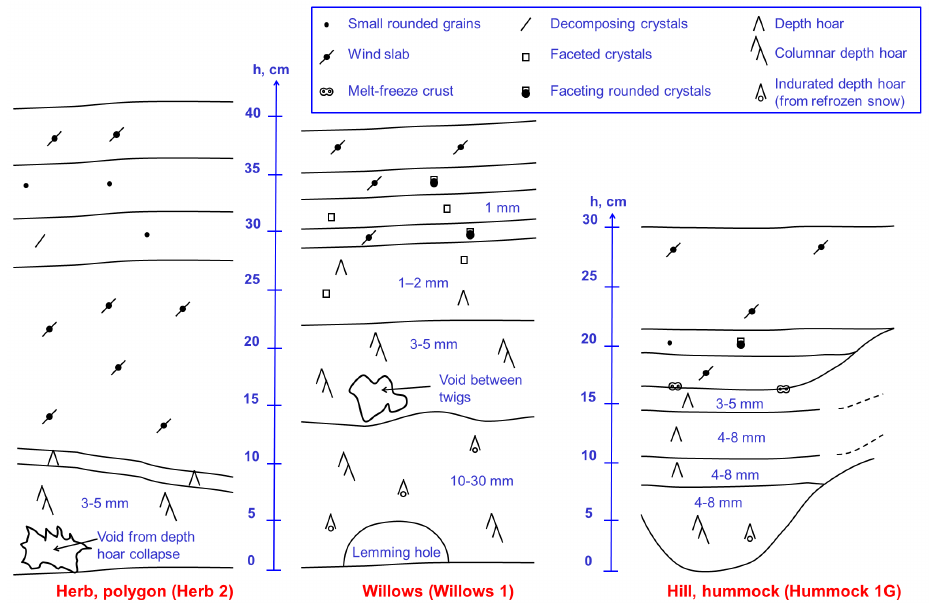
Figure 4. Simplified snow stratigraphy on herb tundra (polygons area), in the large shrub area, where shrubs reached 30 to 35cm in height, and on the NW-facing slopes with hummocks, in May 2015. Pit names are mentioned in parentheses (Herb 2, etc.) to allow correspondence with data in Table 2. The size (largest dimension) of depth hoar and faceted crystals is indicated. Grains in wind slabs and small rounded grains were in the range 0.2 to 0.3mm. A new symbol is proposed for indurated depth hoar formed from refrozen